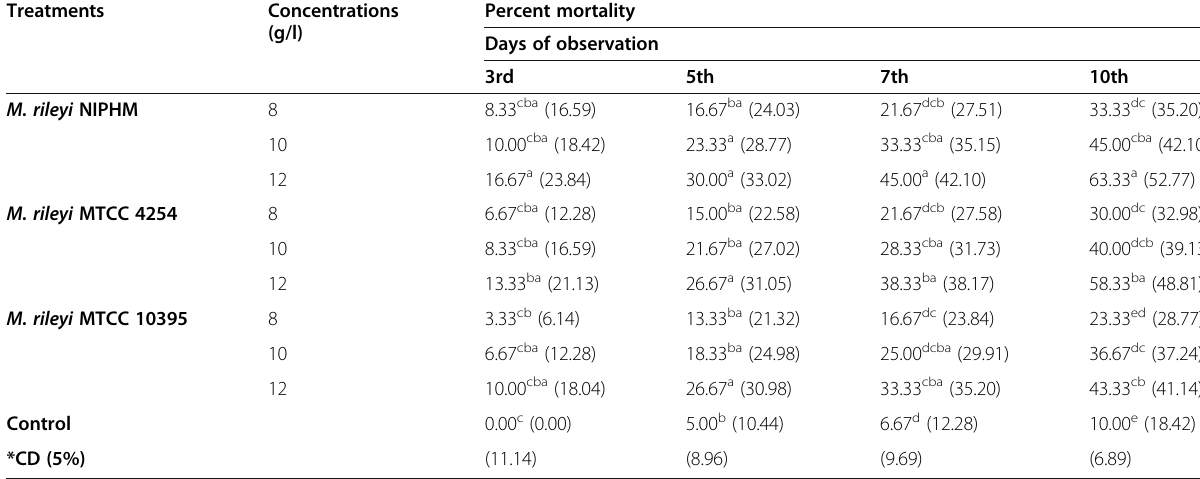
Table 1 Bio-efficacy of Metarhizium rileyi formulations against Spodoptera litura